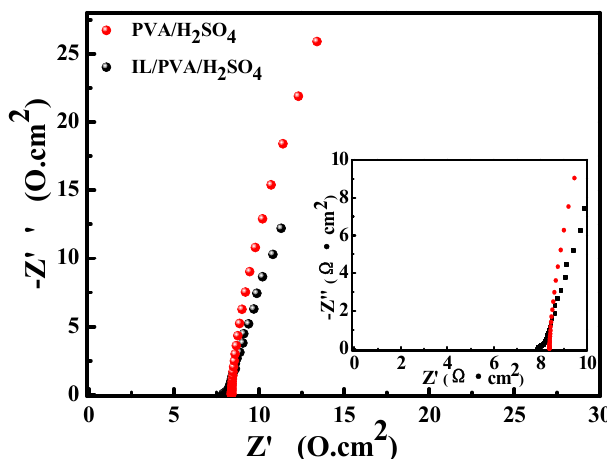
Figure 4. Electrochemical impedance spectra of the SSC based on IL / PVA / H 2 SO 4 and PVA / H 2 SO 4 GPEs and a magnified view of the high-frequency region. Table 1. Resistance values of the SSC based on IL / PVA / H 2 SO 4 and PVA / H 2 SO 4.